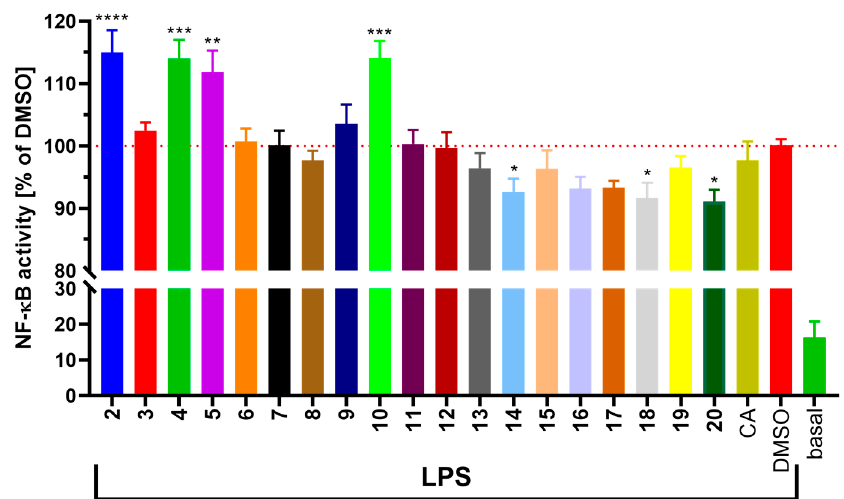
Figure 1. Effect of tested compounds on activity of transcription factor NF- κ B. THP1-Blue™ NF- κ B cells were pretreated by compounds (1 µM) dissolved in dimethyl sulfoxide (DMSO) for 1 h. Then, lipopolysaccharide (LPS) 1 µg/mL was added to trigger the NF- κ B activation. The activity of NF- κ B was measured 24 h after LPS stimulation using QuantiBlue™ assay. The graph represents mean ± SEM (n = 9). The red dotted line shows the value of the DMSO-only treated group. Groups were compared with the help of the one-way ANOVA test followed by Fisher’s LSD multiple comparison test. * indicates statistical significance ( p < 0.05) to DMSO group; ** indicates statistical significance ( p < 0.01) to DMSO group; *** indicates statistical significance ( p < 0.001) to DMSO group; **** indicates statistical significance ( p < 0.0001) to DMSO group. CA—cinnamic acid.